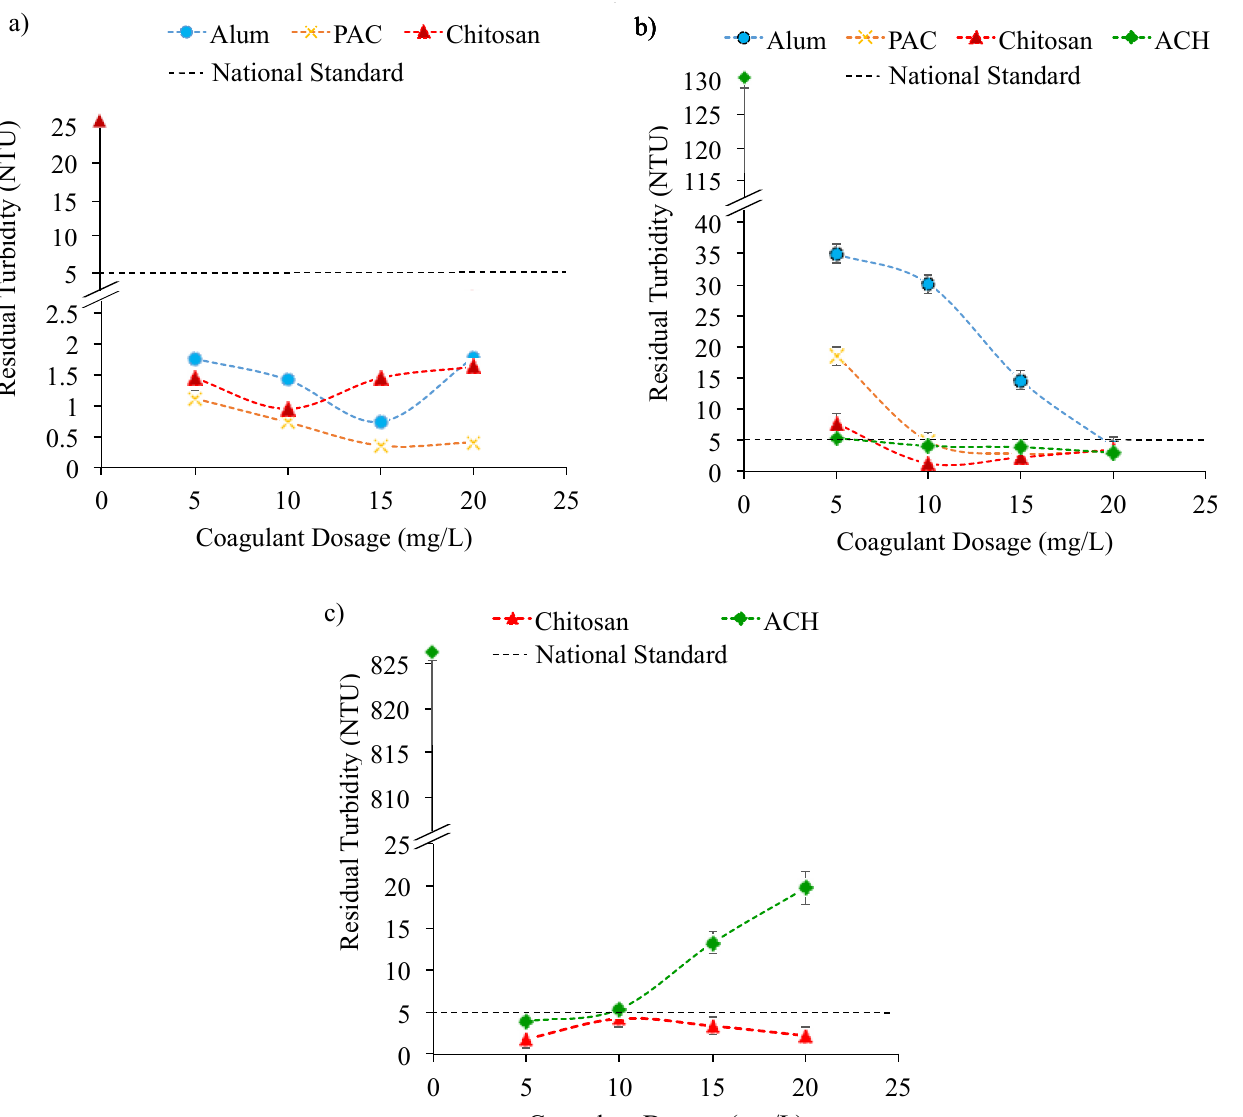
Figure 1. Residual turbidity versus coagulant dosage for different raw water initial turbidity of ( a ) 25.6 NTU (pH 6.63), ( b ) 130.3 NTU (pH 6.80), ( c ) 826.3 NTU (pH 5.21). Raw water turbidity of 826.3 NTU: As the chitosan and ACH demonstrated good performances in achieving residual turbidity as required for the drinking water standard, these coagulants were further tested at higher raw water turbidity of 826.3 NTU. From Figure 1c, even at high initial 826.3 NTU water’ turbidity, chitosan could successfully maintain the residual turbidity of below 5 NTU at dosage below 10 mg/L. Such a phe- nomenon may be explained based on the different pH values of the water samples taken from the WTP, because every turbidity recorded a different pH value. The highest tur- bidity of 826.3 NTU has a pH of 5.21 (see Table 1). Therefore, the good performance of chitosan even at high water turbidity of 826.3 NTU, may be contributed from the high acidity of the water sample. In an acidic condition (at pH < 6), chitosan usually demon- strates high zeta potential of more than 20 mV [39]. At this condition, the amine (NH 2 ) functional groups present in chitosan are highly positively charged and they can effec- tively bind and bridge the negatively charged contaminants and colloidal materials. This could provide electrical neutrality at a low dosage via adsorption, charge neutralization, inter-particle bridging, and hydrophobic flocculation [37,40]. The presence of high number of protons in the solution at low pH conditions could protonate more amine groups of the chitosan molecule, thus, create more sites for adsorption of contami-